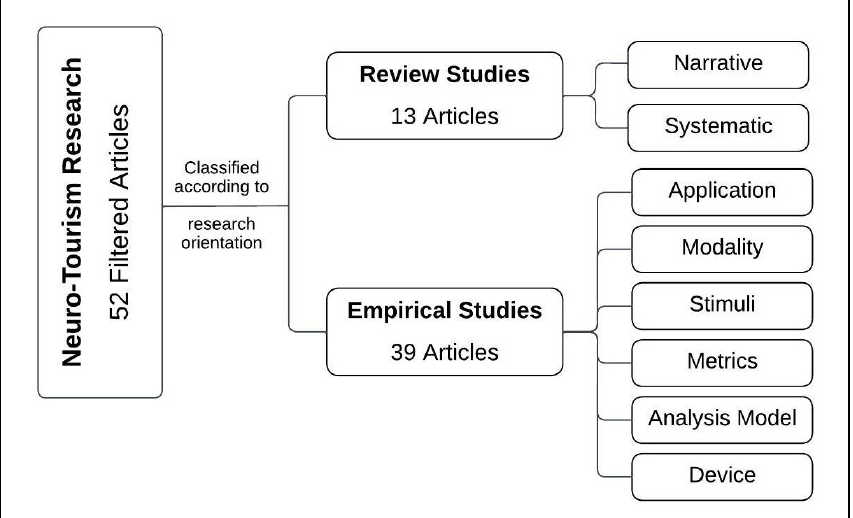
Figure 4. Classi fi cation Schema.